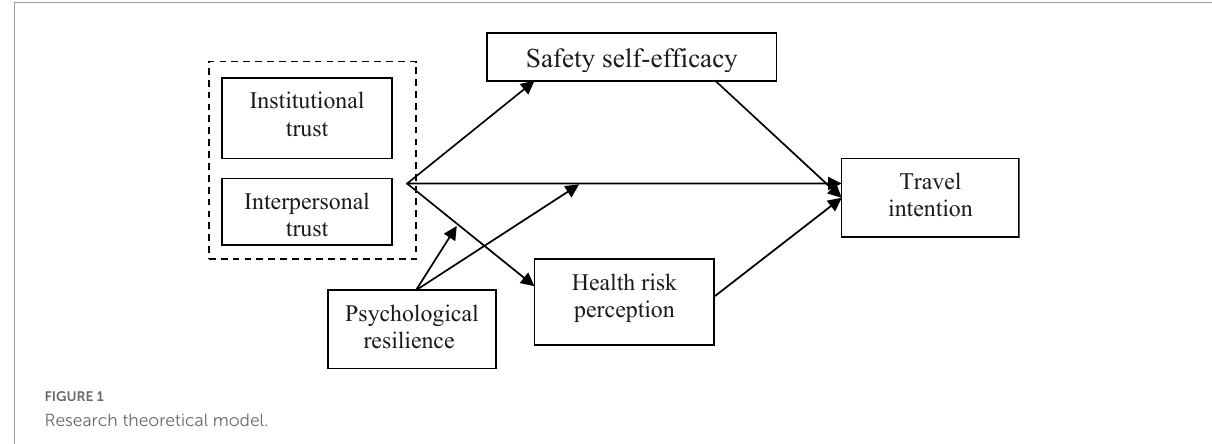
FIGURE1 Research theoretical